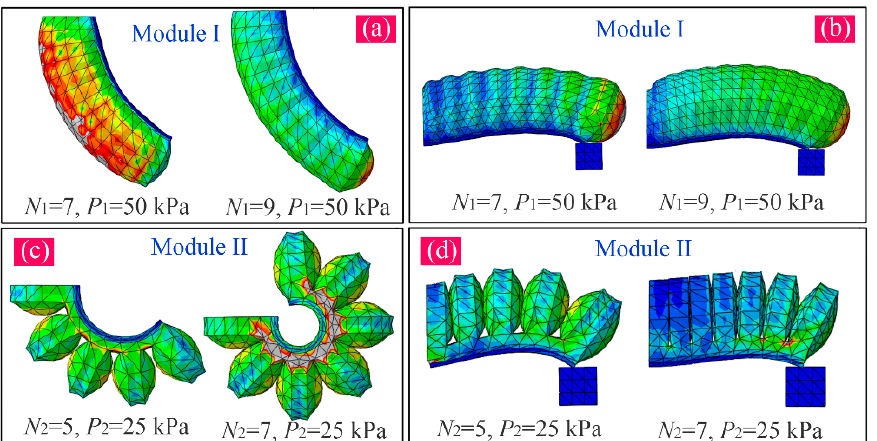
Figure 3. Simulation results of bending and tip force of two modules: ( a ) bending of module I when N 1 = 7 and P 1 = 50 kPa, and N 1 = 9 and P 1 = 50 kPa; ( b ) tip force of module I when N 1 = 7 and P 1 = 50 kPa, and N 1 = 9 and P 1 = 50 kPa; ( c ) bending of module II when N 2 = 5 and P 2 = 25 kPa, and N 2 = 7 and P 2 = 25 kPa; and ( d ) tip force of module II when N 2 = 5 and P 2 = 25 kPa, and N 2 = 7 and P 2 = 25 kPa.